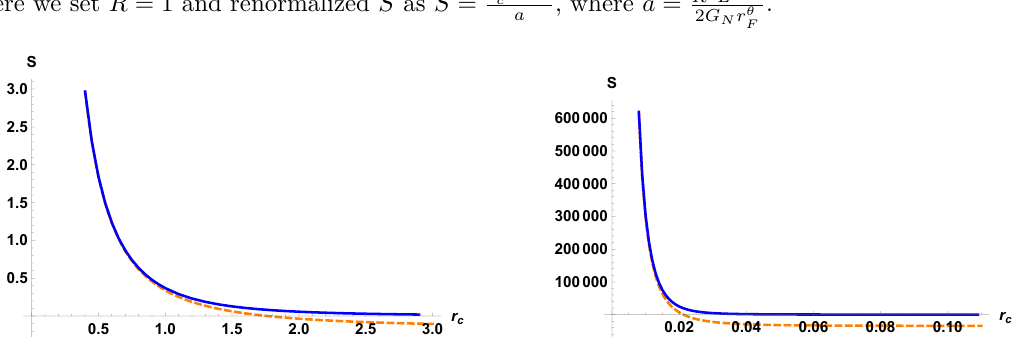
, where a = R d L d − 1 . a 2 G N r θ F